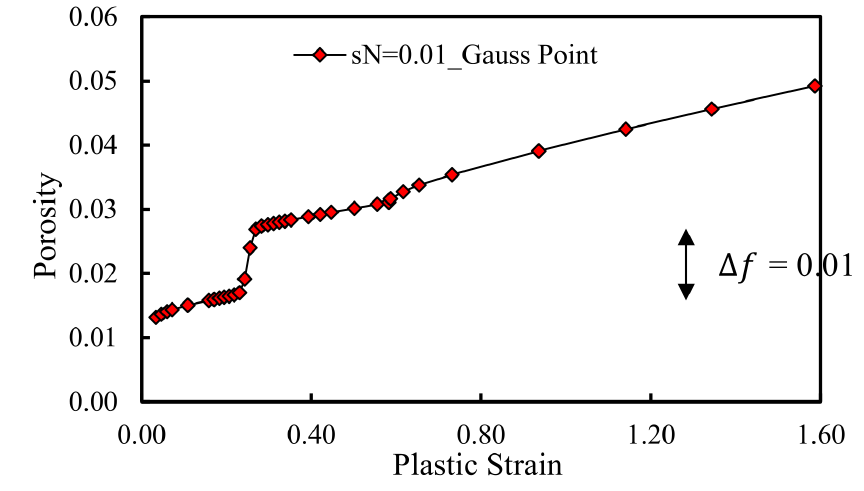
Figure 20. Porosity accumulation due to the occurrence of plastic strain at the Gauss point located immediately after the node containing the crack